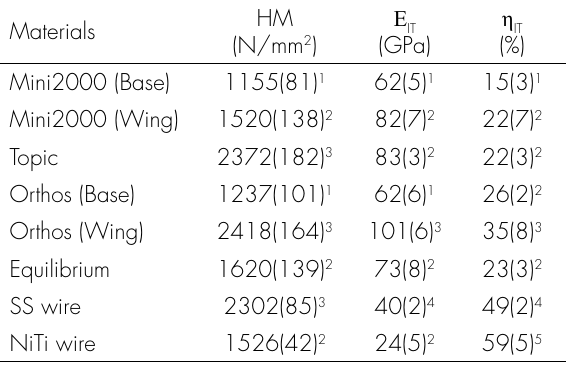
Same superscripts denote mean values without statistically significant